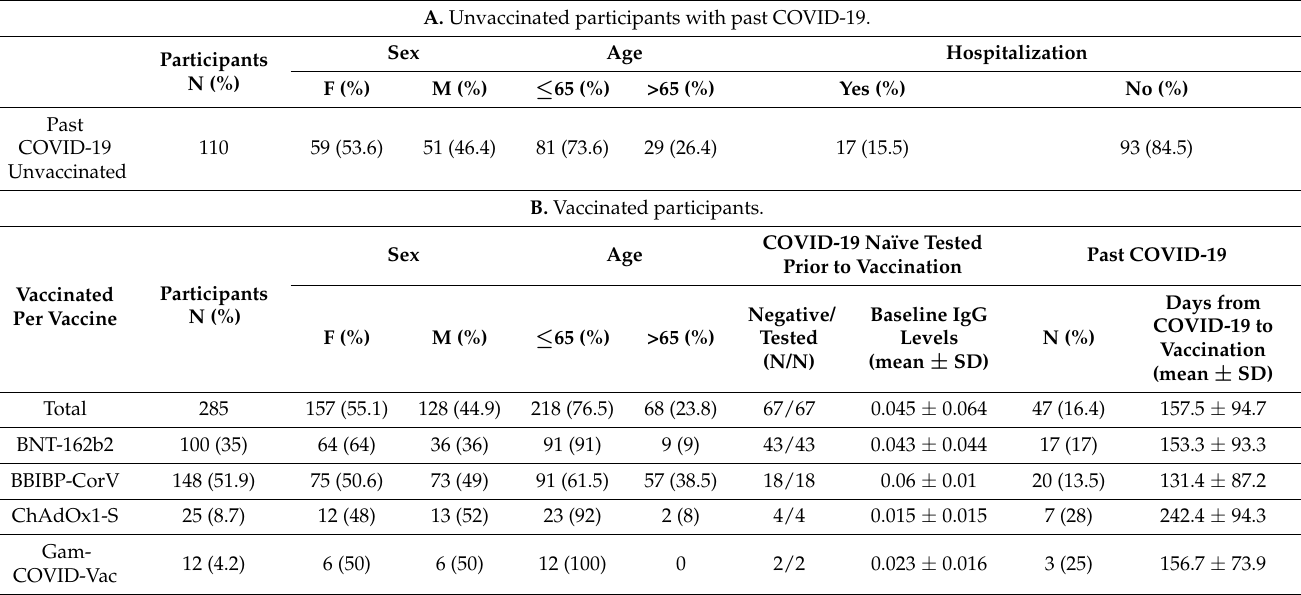
Table 1. Characteristics of the study group